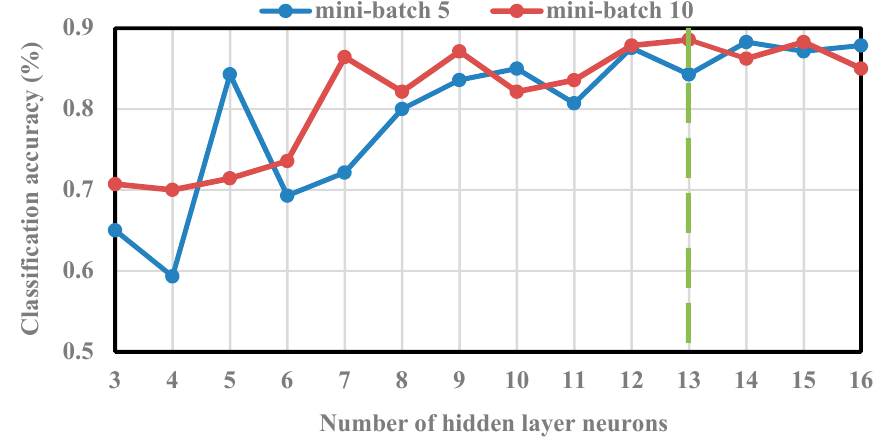
Figure 9. Classification accuracy using deep neural networks (DNN).